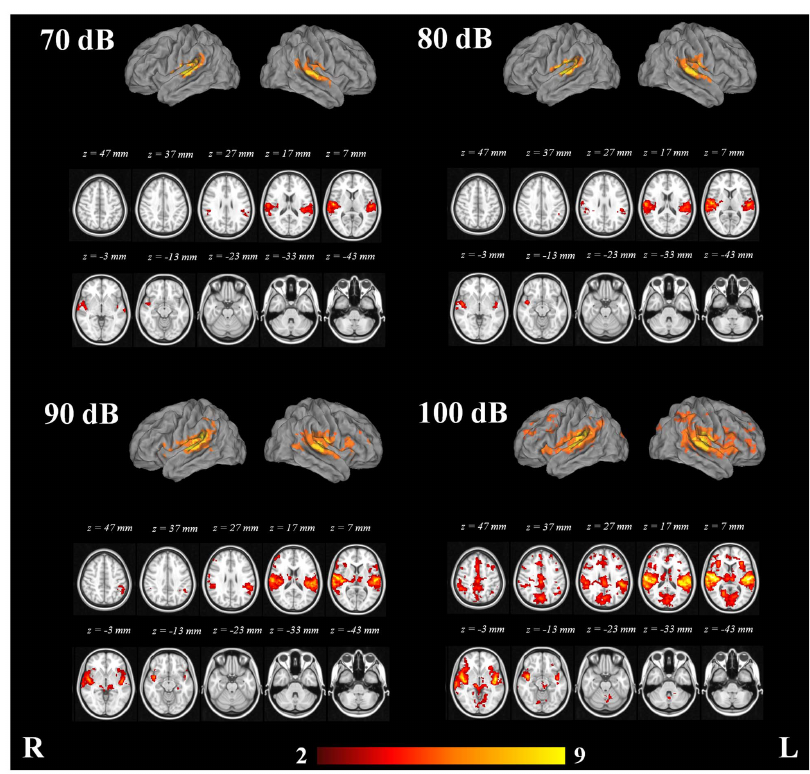
Figure 3. Mixed effects group analysis (n=16) of the fMRI activation related to the 70, 80, 90 and 100 dB stimuli. Color bar represents Z-scores.